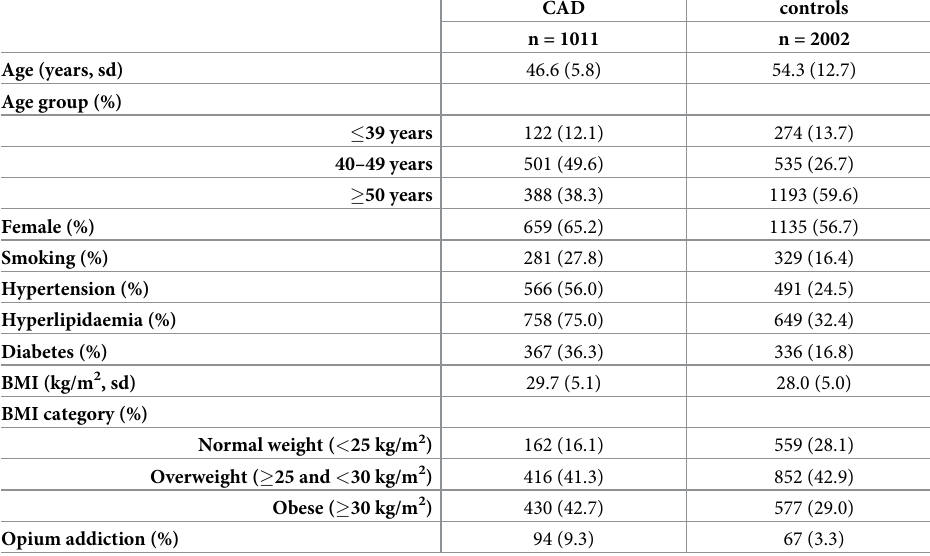
Table 1. Clinical characteristics and cardiovascular risk factors of incident cases with coronary artery disease (CAD) and